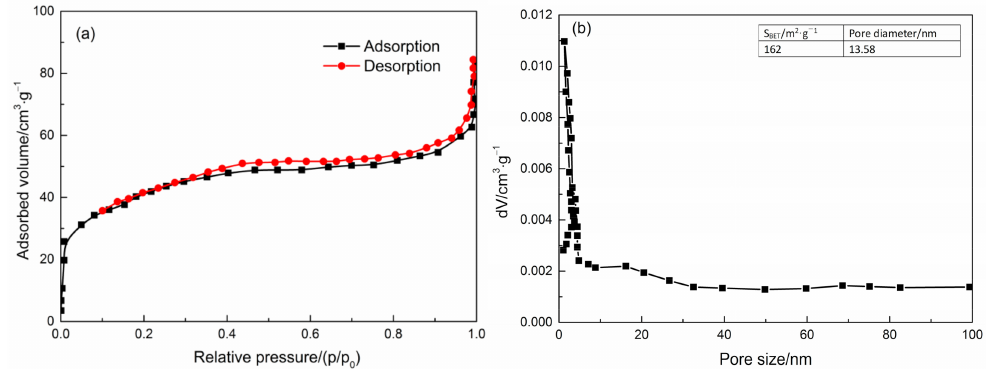
Figure 6. ( a ) Nitrogen adsorption—desorption isotherms curve of adsorbent; ( b ) with the BJH pore -size distribution curve of adsorbent.